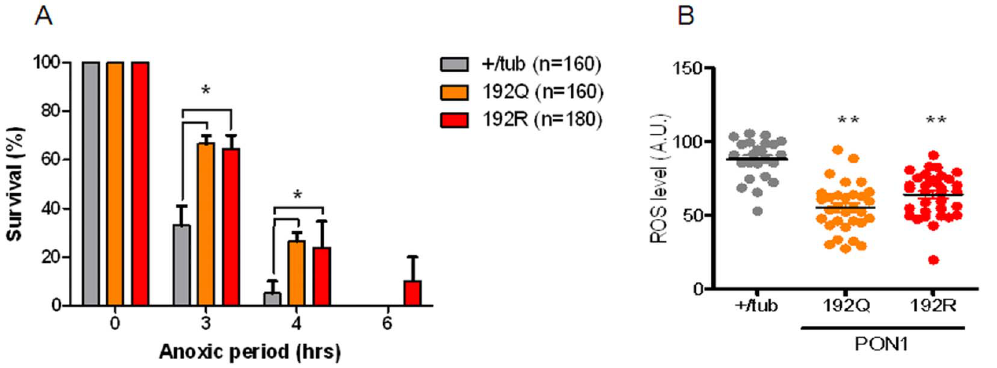
Figure 3. Survival and ROS of transgenic flies expression PON1 variants. A) + /tub, 192Q and 192R transgenic flies were exposed to different anoxia periods, survival was registered 24 hrs after reoxygenation. B) ROS level in flies measured with dihydroethdium staining. *p , 0.05, ** p , 0.01 when compared with + /tub.